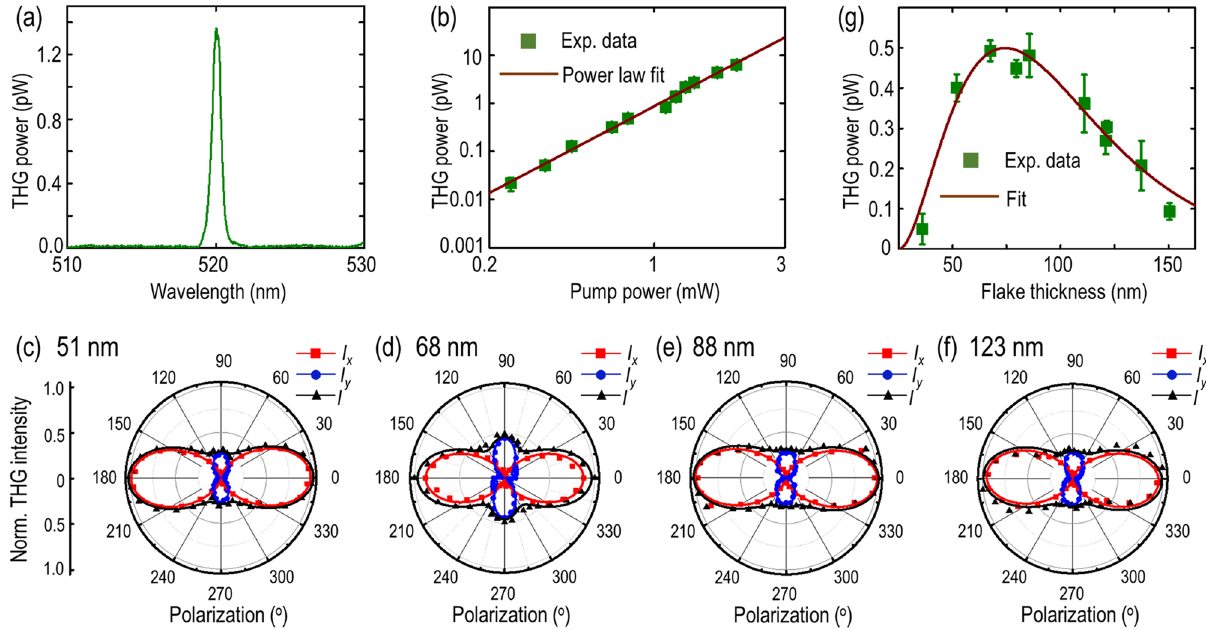
Figure 7. Anisotropic nonlinear optical response in gerstleyite crystal. ( a ) Collected THG emission spectrum with the peak wavelength at 520 nm from the 88 nm-thick gerstleyite flake. ( b ) Double log-scale plot of THG power as a function of the incident pump power. The linear fit with a slope of 3.00 (± 0.03) endorses the third- harmonic process. The measured values are indicated with green squares, while the power law fit is shown with brown solid line. ( c – f ) Angular dependence of THG power as a function of the incident linear polarization angle for four different gerstleyite flakes with thicknesses of 51, 68, 88 and 123 nm. The measured values along x -component ( I x ), y -component ( I y ) and total ( I ) are denoted with red squares, blue dots and black triangles, respectively. The corresponding theoretical fittings are shown with solid curves. ( g ) Evolution of THG emission power as a function of the gerstleyite flake thickness. The measured values are indicated with green squares and the corresponding theoretical fit is plotted as brown solid